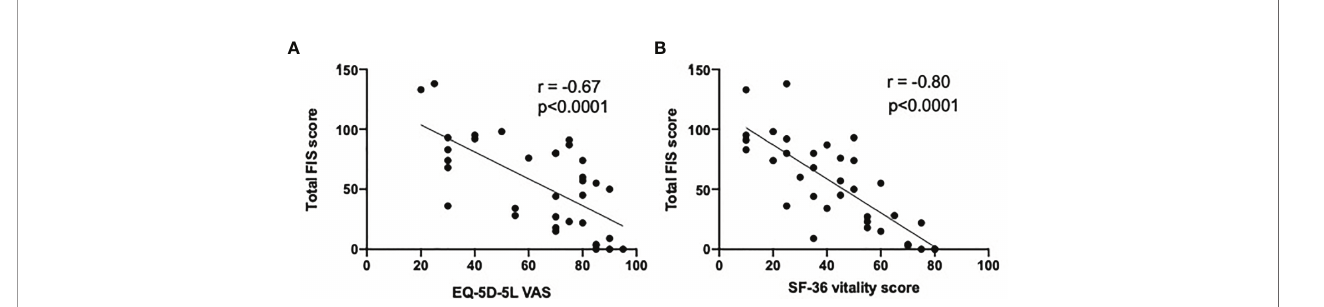
FIGURE 3 | Correlation between EQ-5D-5L VAS score and FIS-total score and SF-36 vitality scores. There was a negative correlation between EQ-5D-5L VAS score and total FIS score (A) and SF-36 vitality score (B) . r, Spearman correlation coef fi cient.